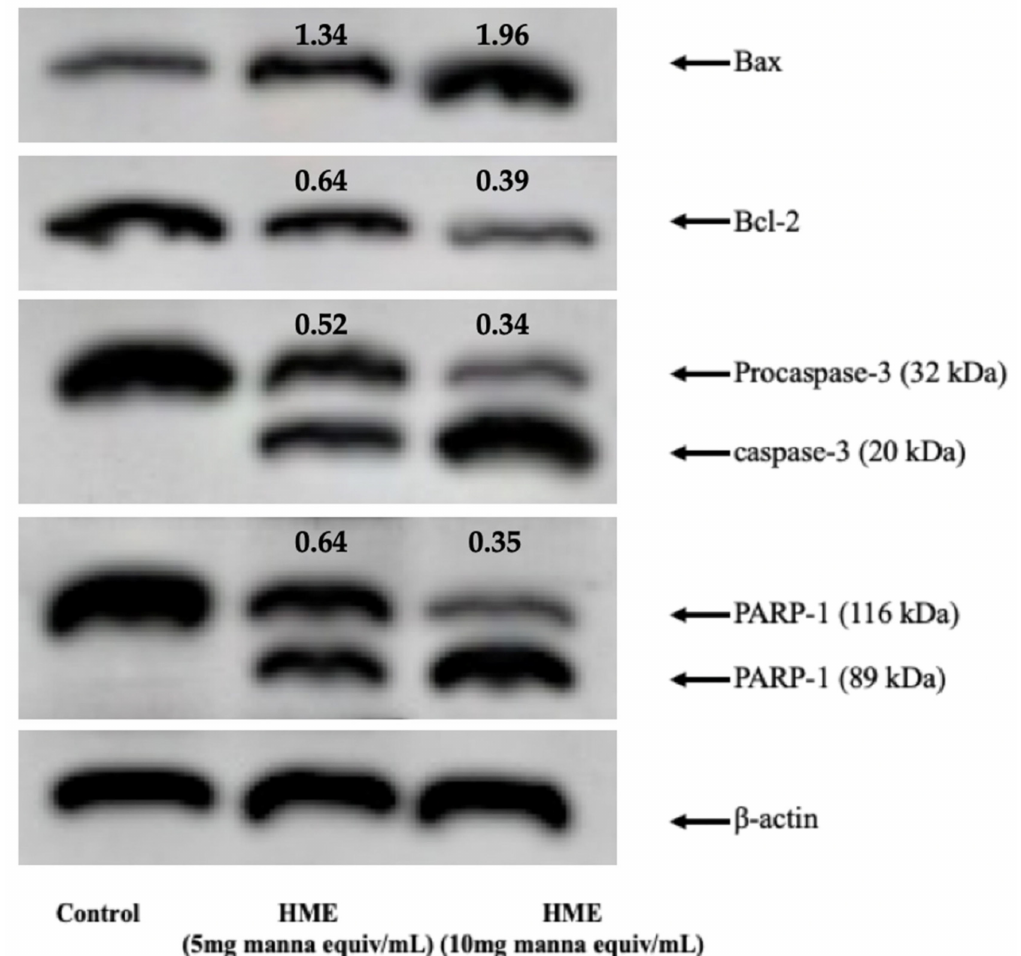
Figure 5. E ff ect of HME on the levels of apoptotic proteins on HCT-116 cells. Cells were treated for 24 h as described in Methods. Representative images of immunoblotting analysis of Bax, Bcl-2, procaspase-3 and PARP-1 levels of three separate experiments with comparable results; values were normalized on β -actin levels. Numbers above the bands represent the densitometric ratio with the